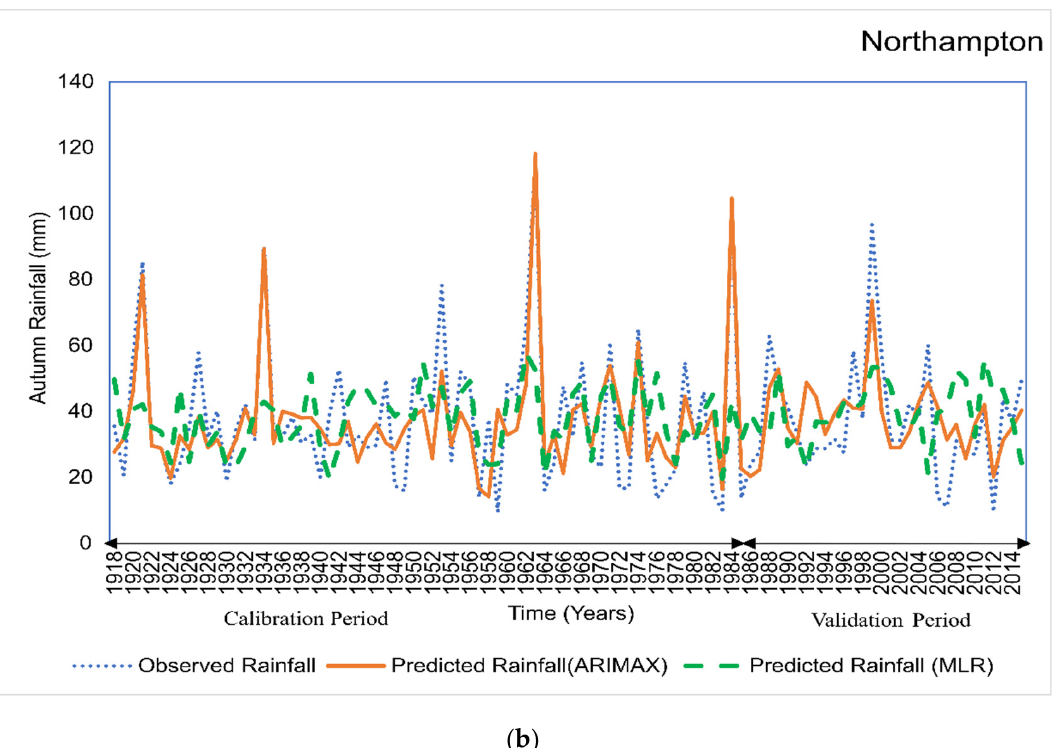
Figure 7. Prediction performance of the developed models for ( a ) Albany and ( b ) Northampton.